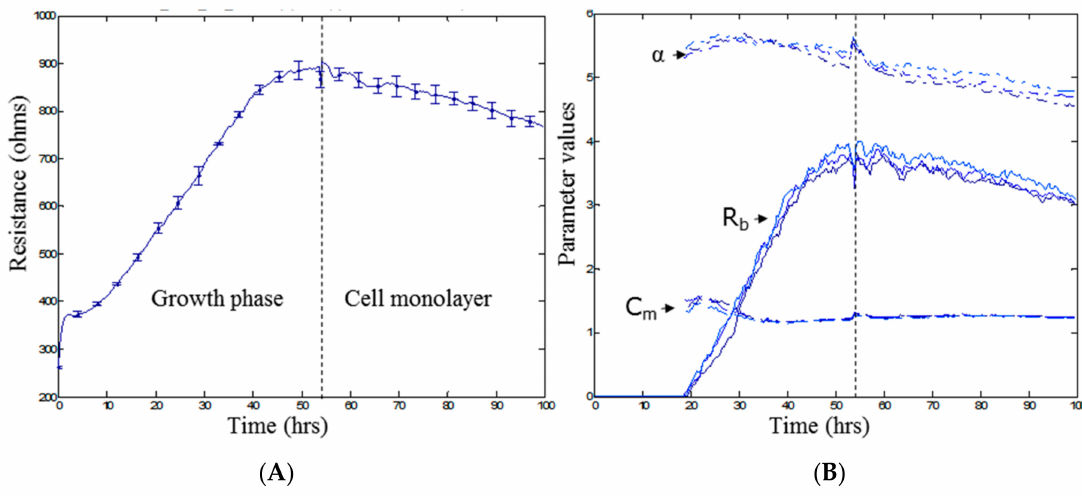
Figure 3. Monitoring parameters R ( Ω ), R b ( Ω cm 2 ), α ( Ω 0.5 cm), and C m ( µ F/cm 2 ). ( A ) Time course of resistance magnitude at 4000 Hz for endothelial cells. Influence of the cell growth phase and formation of a cell monolayer on resistance; ( B ) Time course of modelled parameter magnitudes. Illustration of the changes in the three parameters R b, α , and C m as a result of cell growth and monolayer formation as can be seen by an increase in R b overtime. Time point 0 h denotes the time at which cells were seeded at 20,000 cells per well. Data ( A ) show the mean ± SD (n = 3 wells) of one independent experiment representative of three experimental